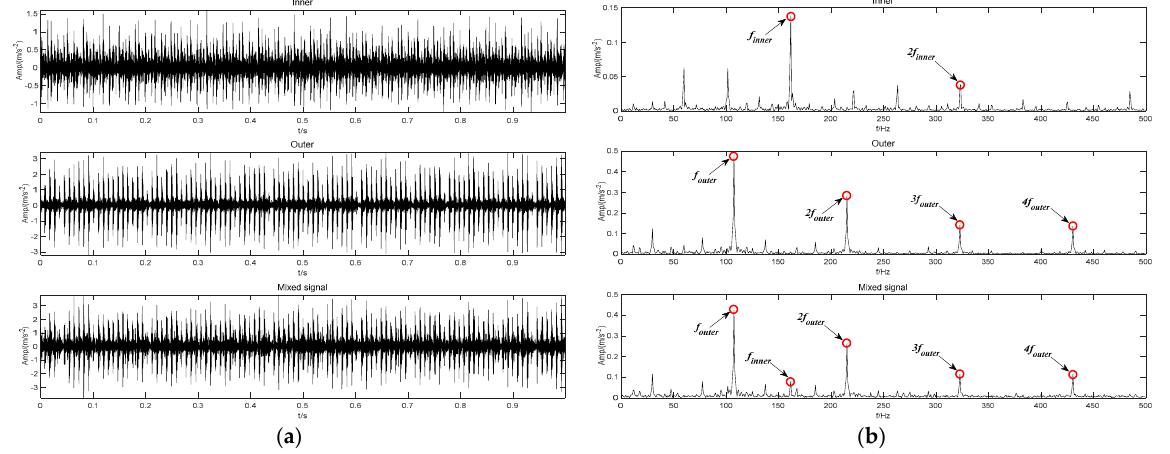
Figure 15. Original fault vibration signal: ( a ) Time-domain fault waveform. ( b ) Envelope spectrum.